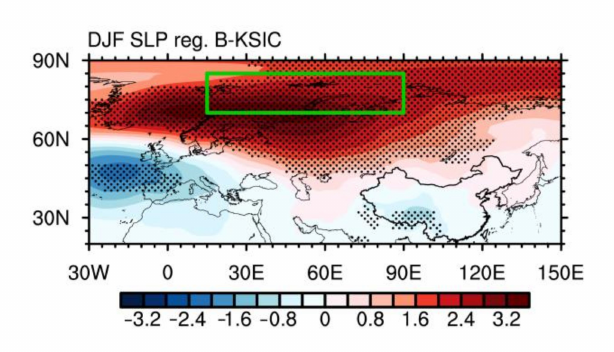
Figure 13. Linear regression of winter SLP anomaly (shaded, unit: hPa) on autumn B-KSIC during 1979–2015. The green box indicates the key area of sea ice (70 ◦ N–85 ◦ N, 15 ◦ E–90 ◦ E). The dotted region indicates significance at the 95% level from the t test.